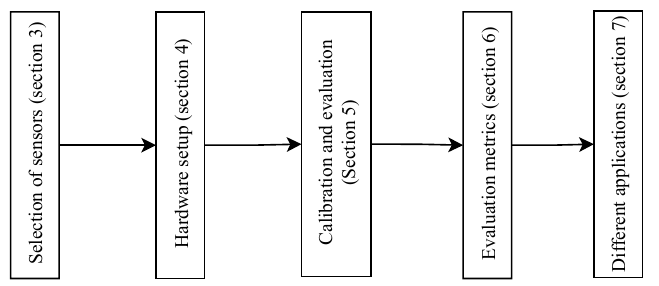
Figure 2. Flow chart illustrating the road-map of the